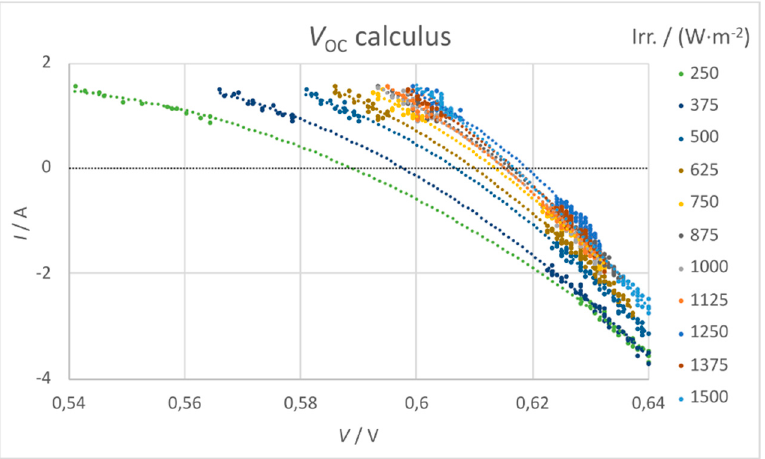
Figure 21. Details of the same I-V curve (Figure 20) corresponding to the first and fourth quadrants.